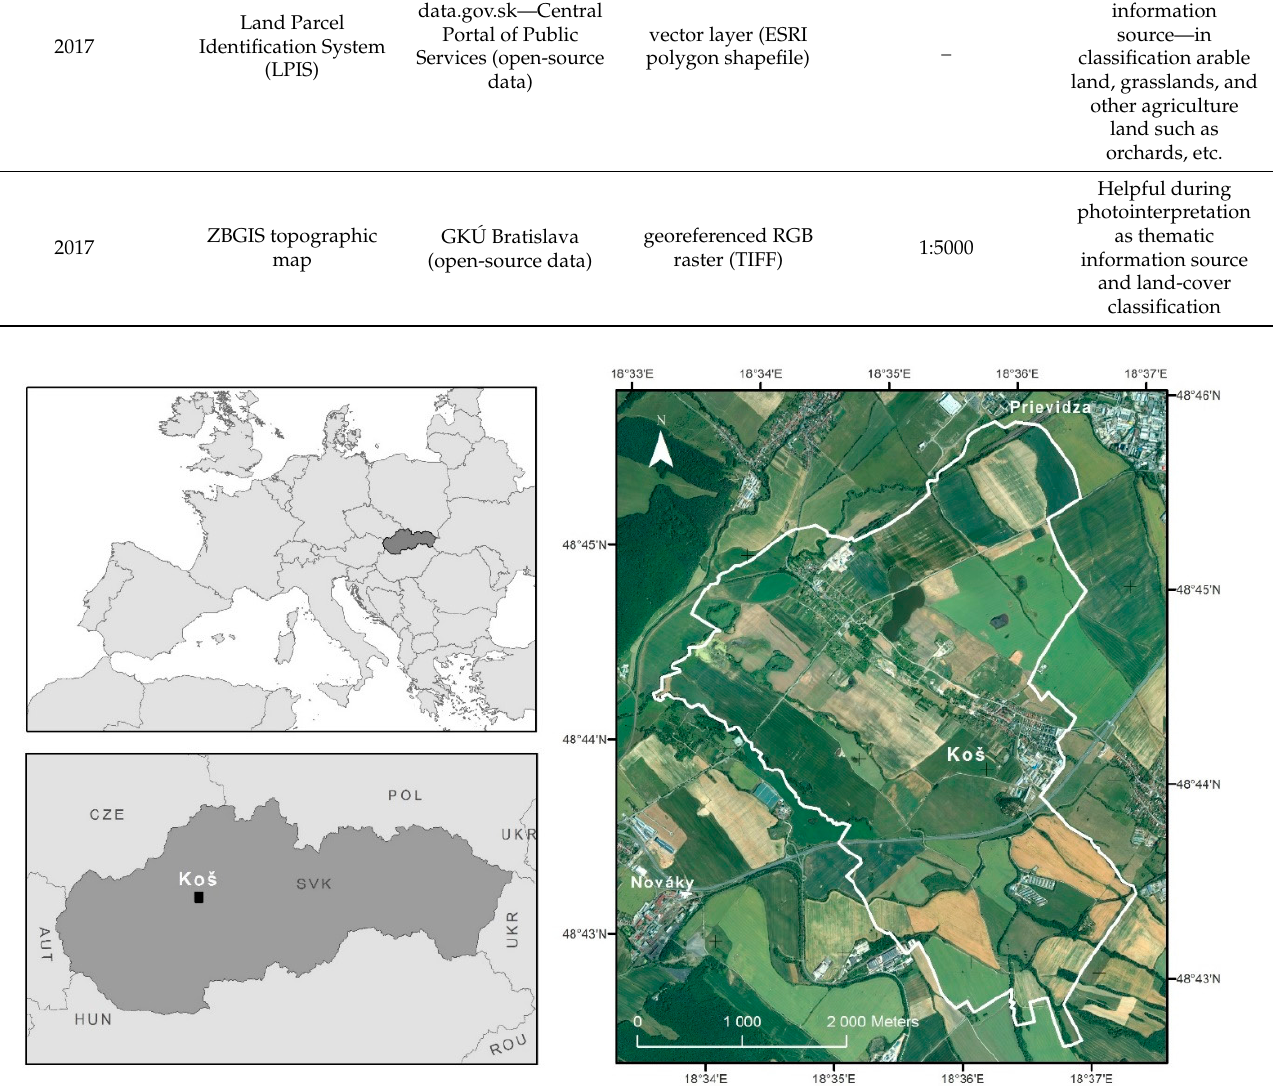
Figure 1. Location of the study area.